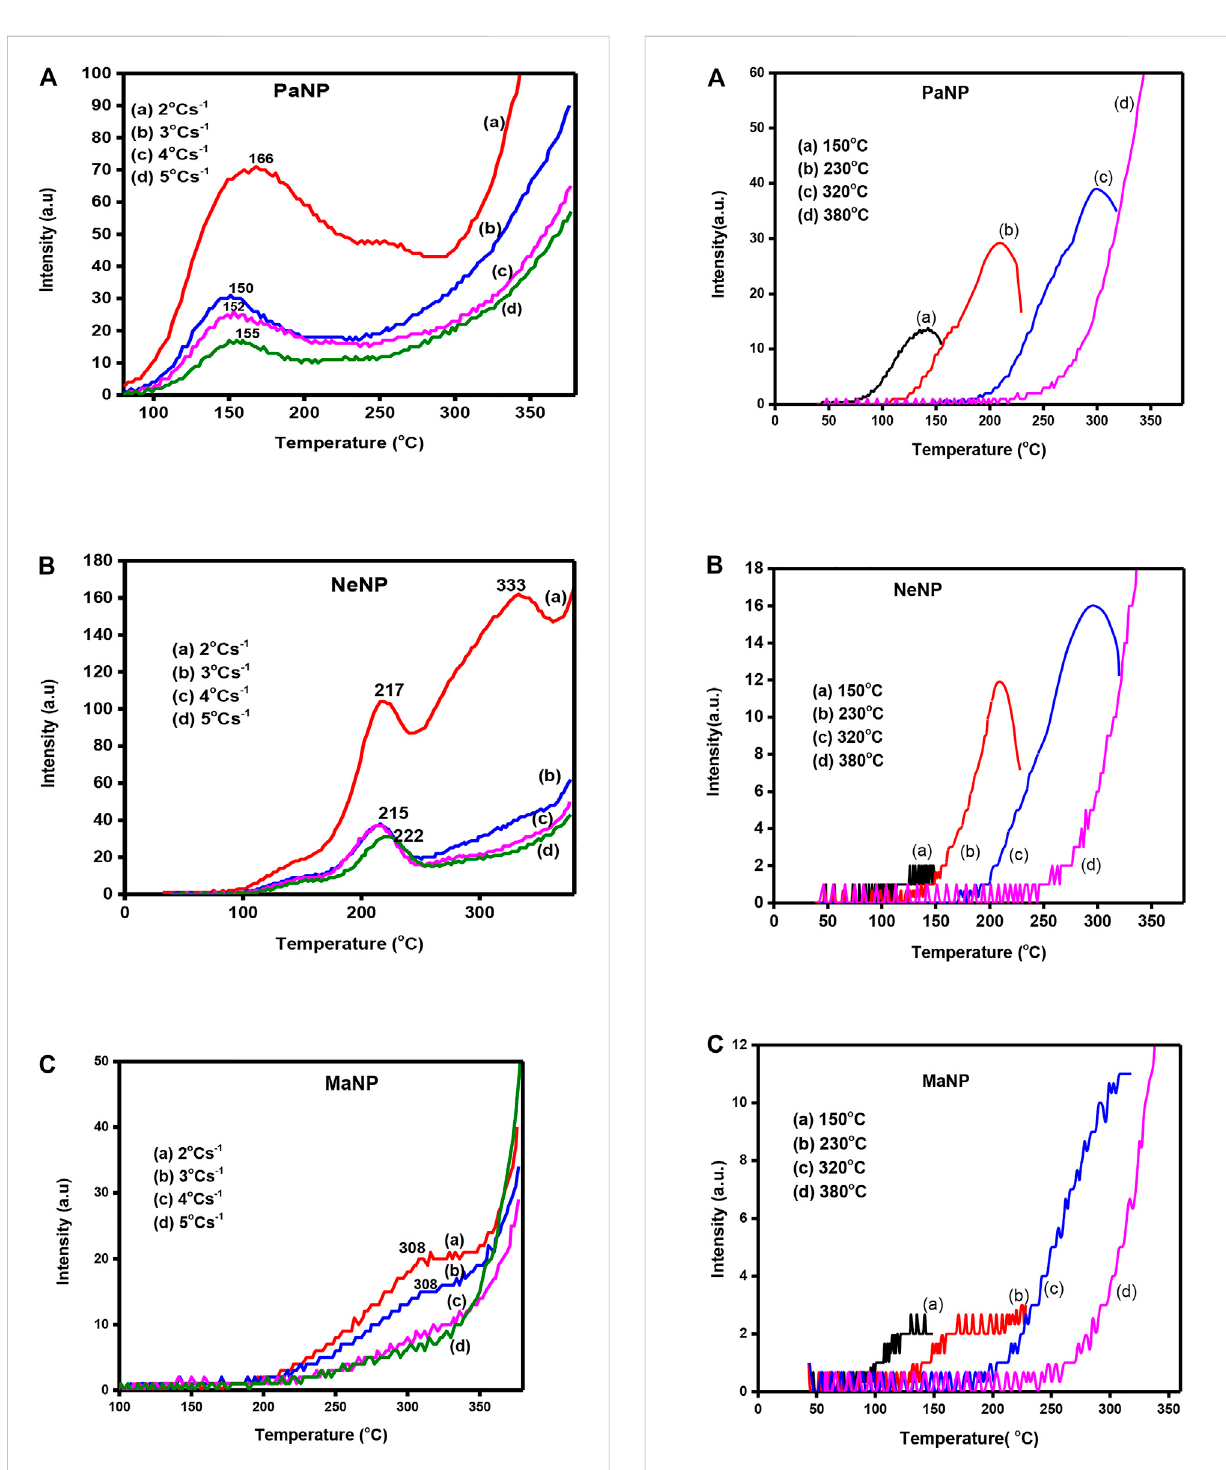
FIGURE 8 The TL glow curves recorded for different heating rate in (A) PaNP, (B) NeNP, and (C) MaNP.